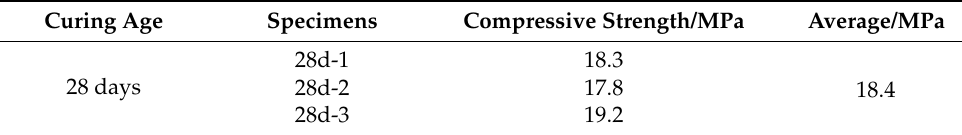
Figure 5. Grout properties test. ( a ) Testing machine. ( b ) Flexural test damage pattern. ( c ) Compression test damage pattern. Table 5. Results of grouting material flexural strength test.